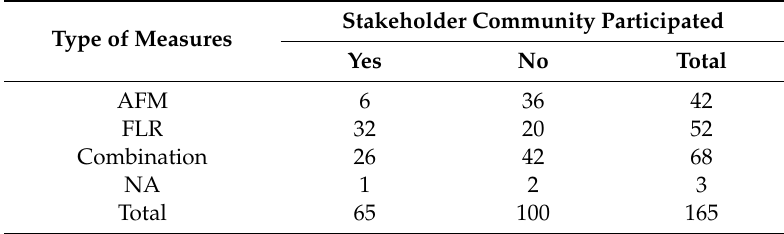
Figure 8. Level of agreement to the statement “The participation of all stakeholders was important for the success of the project” by types of projects. Table 4. Participation of the local community in the projects by project type. NA corresponds to respondents that did not provide the type of measures that were